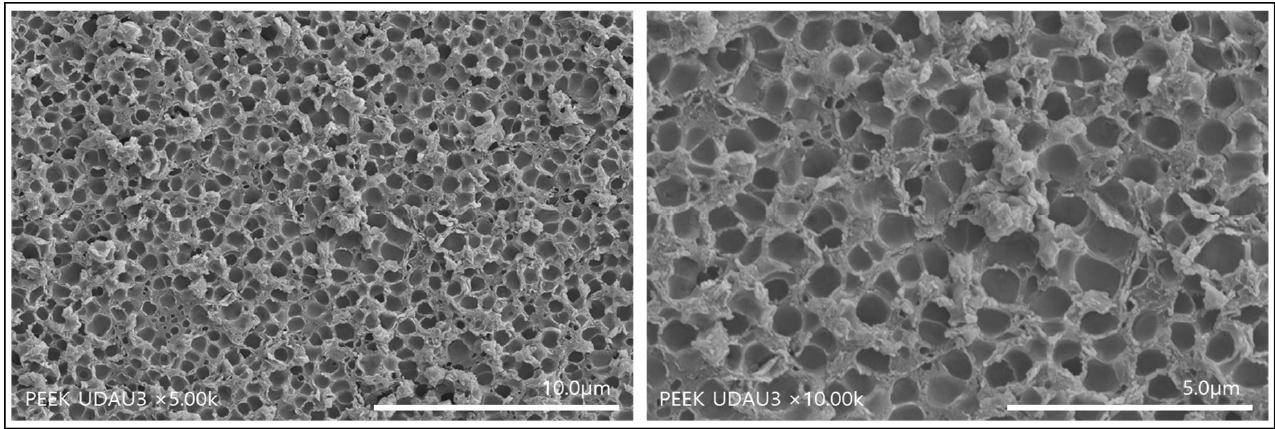
Figure 3. SEM images of PEEK implants at various magnifications after treatment with a mixed acid of sulfuric acid and nitric acid under ultrasound for 90 s and then washing with distilled water for 6 h under ultrasound.